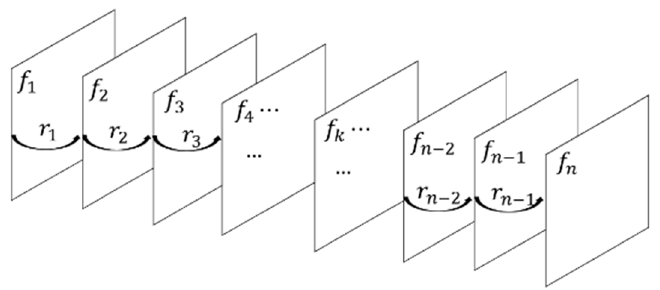
Figure 2. Inter-frame correlation.